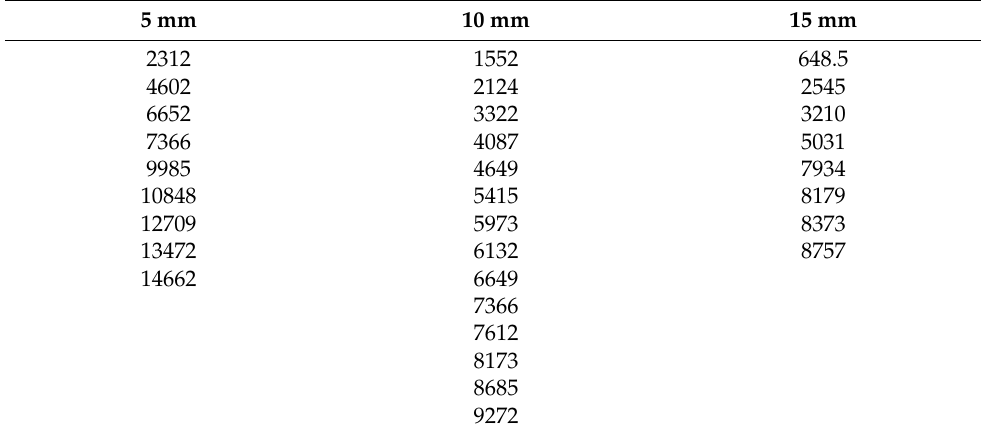
Figure 11. Nyquist diagram for membranes with diameters of 5 mm ( a ), 10 mm ( b ), and 15 mm ( c ) for the center location (blue curve) and edge location (green curve). Table 1. Resonant frequencies detected by circular fit method at the center of the membrane (Hz).